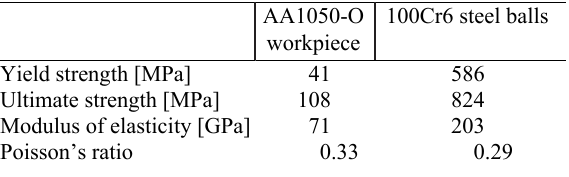
Table 1. Mechanical properties of the interacting surfaces in